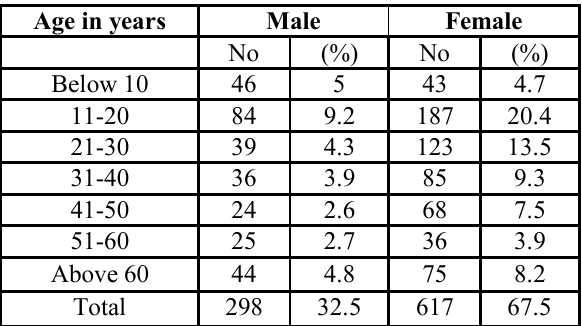
Table-1: Age and sex distribution of patients